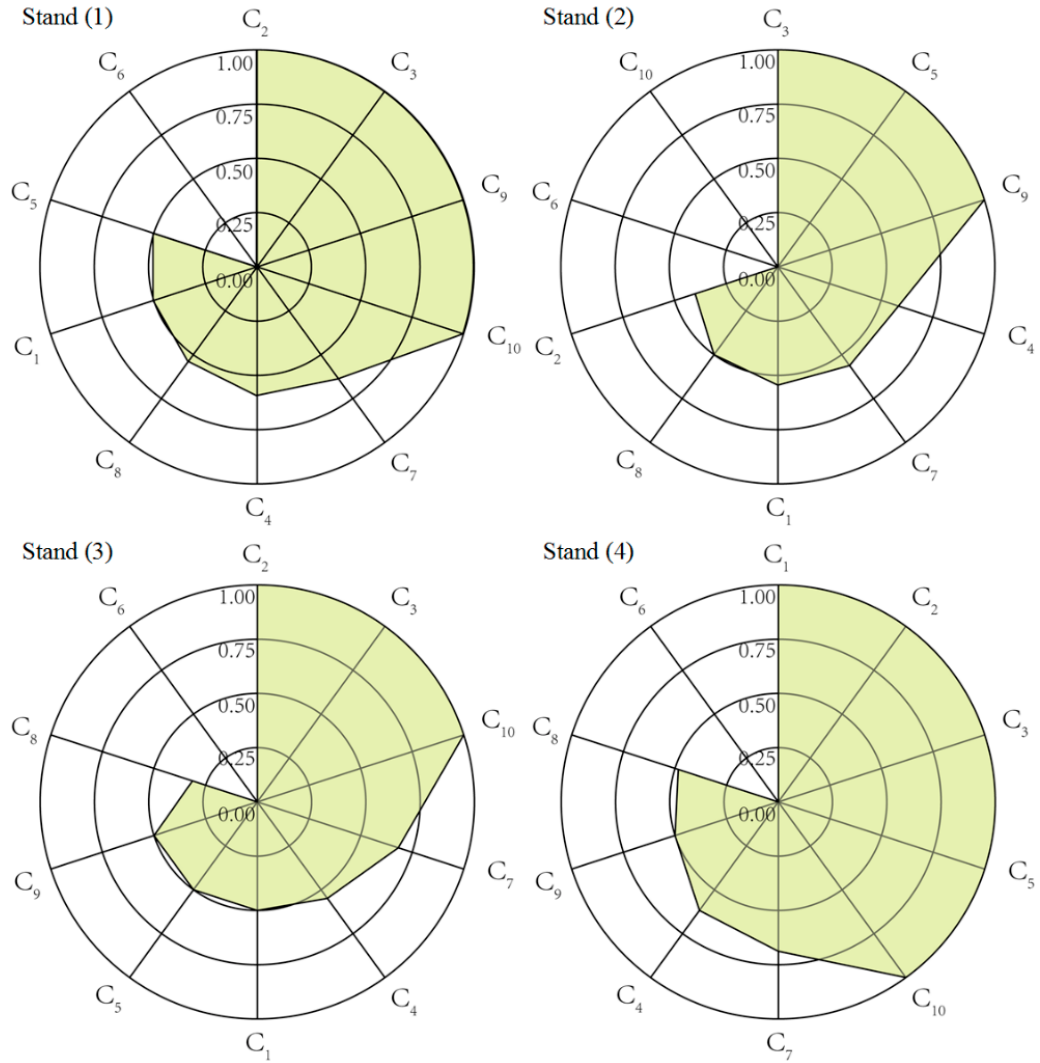
Figure 6. Unit circle of Q. aliena var. acuteserrata broad-leaved mixed forest (stands (1) and (2)) and P. koraiensis broad-leaved mixed forest (stands (3) and (4)).